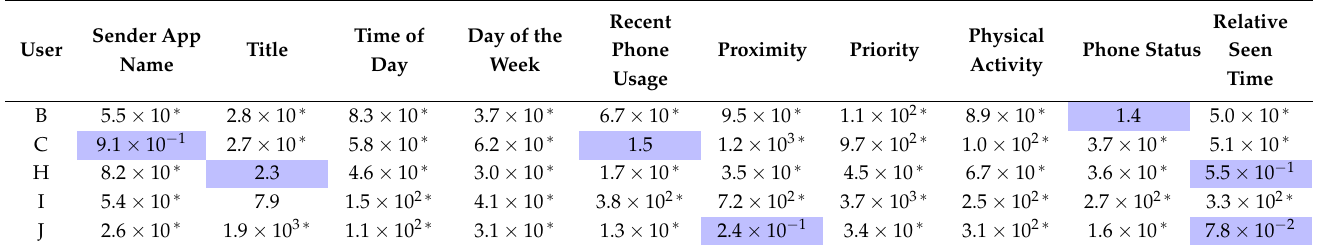
Table 5. Long-term feature analysis with chi-square test. * denotes the p -value < 0.05. The colored cells indicate long-term features (time-invariant